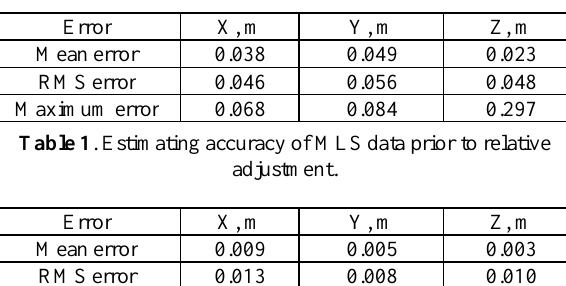
Figure 7 . The second example of identified tie points on pole- like infrastructures and vegetation.